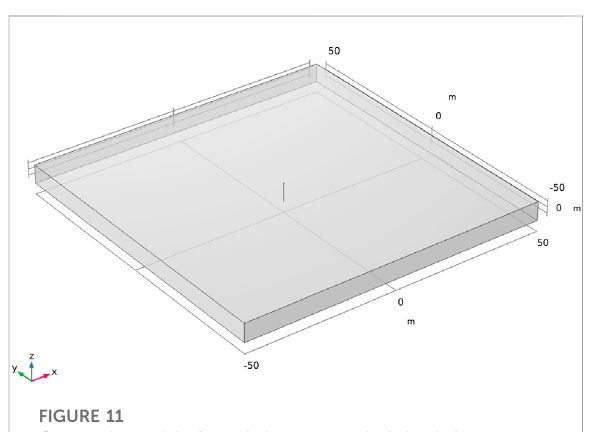
FIGURE 11 Geometric model of gas drainage numerical